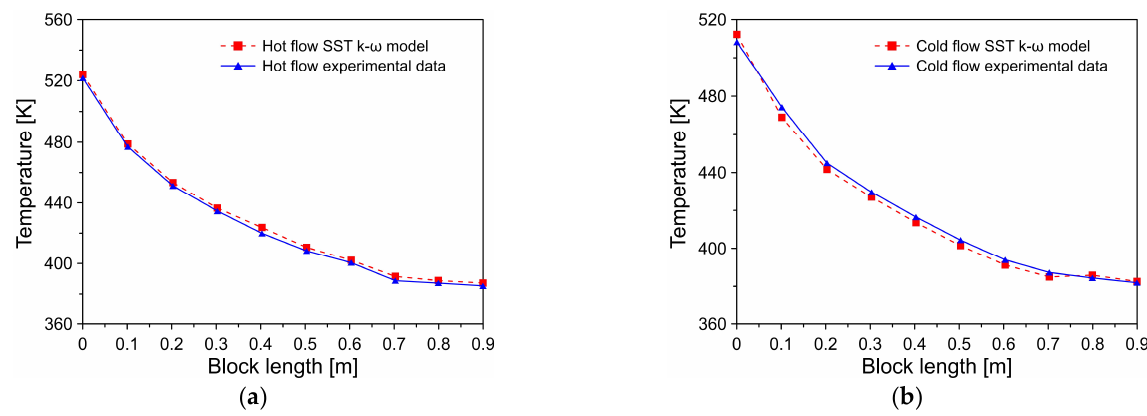
Figure 6. Numerical validation of the SST k − ω model and thermodynamic model: ( a ) hot flow; ( b ) cold flow.